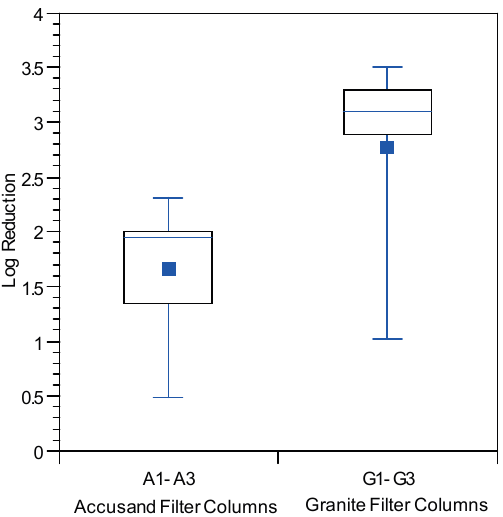
Figure 10. Echovirus 12 reductions for Accusand media columns and granite media columns in Column Test No. 1 for samples collected throughout the eight-week experiment. N = 11 for Accusand and 11 for granite